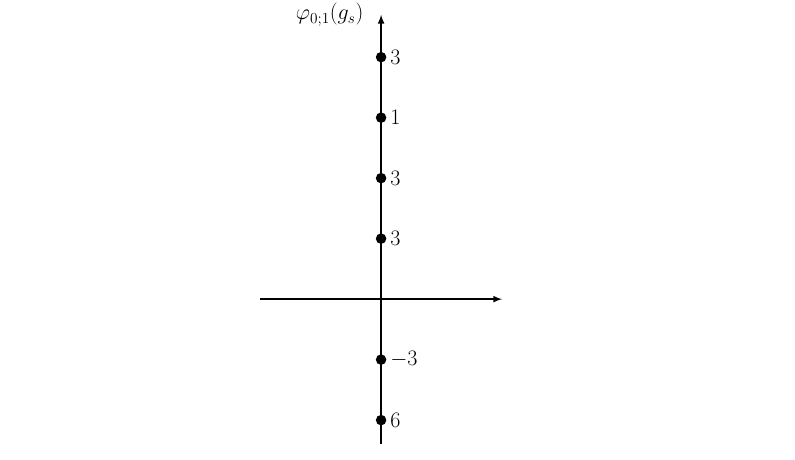
Figure 8: Stokes constants for the asymptotic series from the first trace of local (cid:80) 2